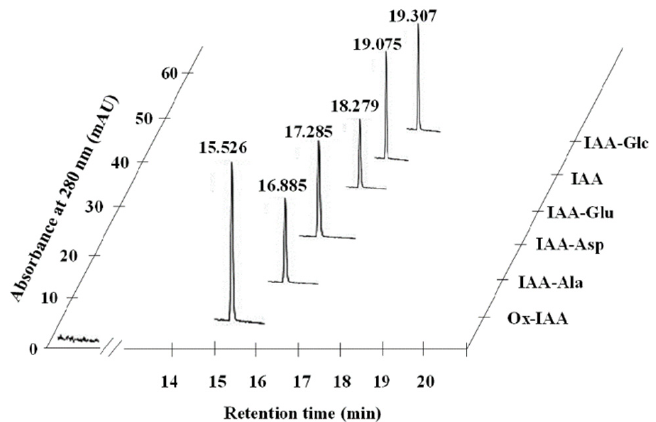
Figure 5. Separation of standards (1 pmol) of IAA and IAA conjugates under HPLC analysis. Ox-IAA—2-oxindole-3-acetic acid; IAA-Ala—indole-3-acetyl-L-alanine; IAA-Asp—indole-3-acetyl-L- aspartic acid; IAA-Glu—indole-3-acetyl-L-glutamic acid; IAA—indole-3-acetic acid; IAA-Glc—IAA complex with